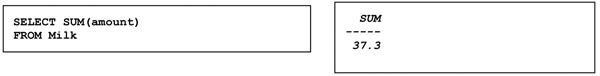
Query to compute total amount of milk over all farms